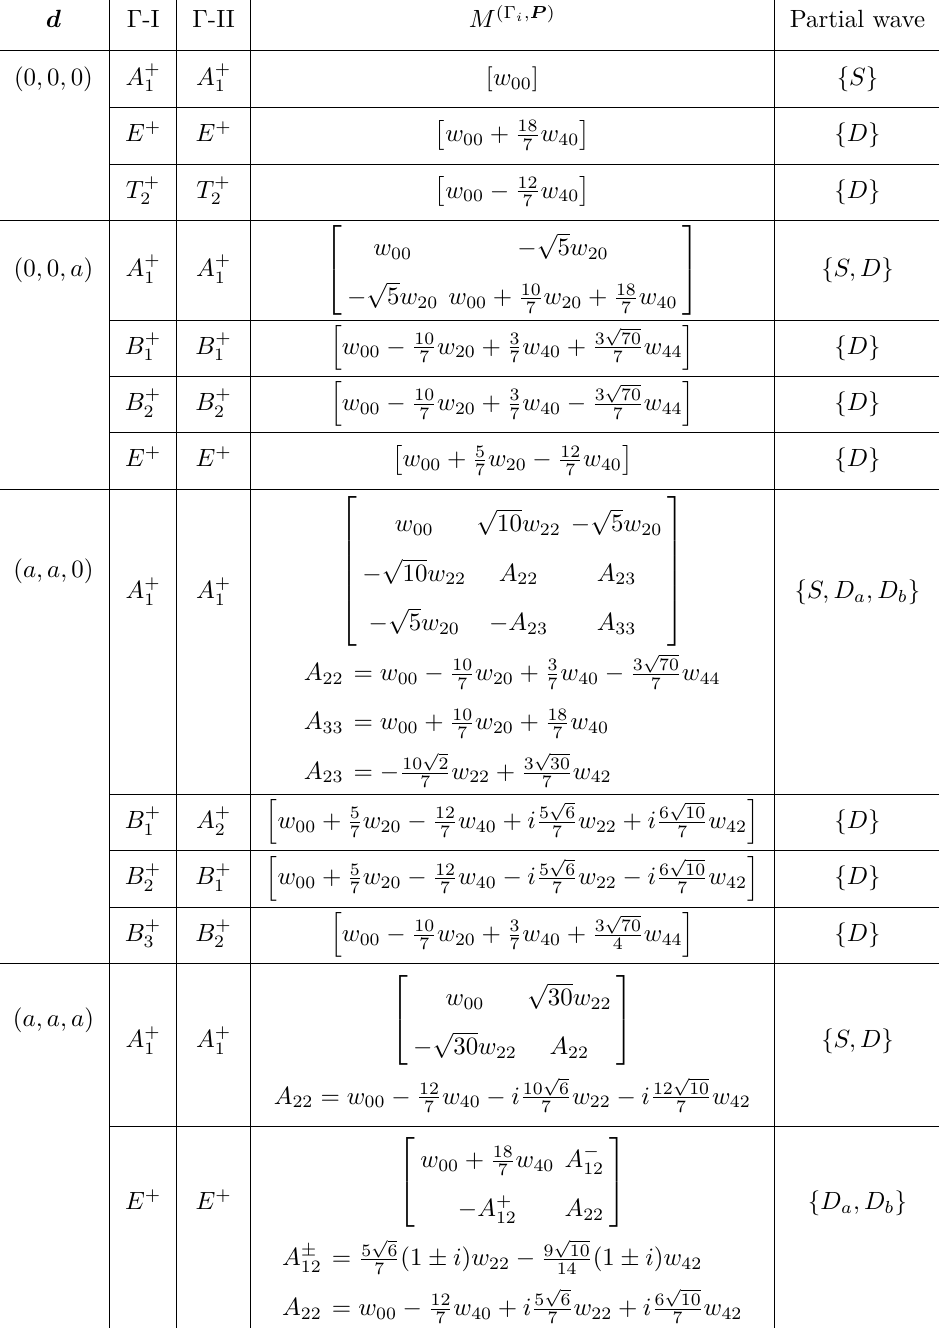
Table 11 . Lüscher’s quantization conditions for systems with even parity [6]. We label the multiple occurrences of D-wave in some irreps with D a and D b